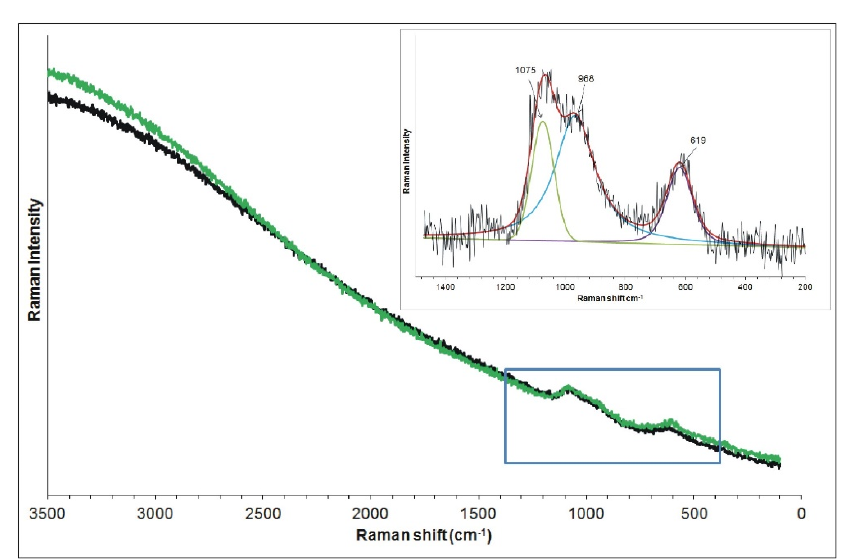
Figure 11. Representative characteristic Raman spectra of the surface of the black bead.